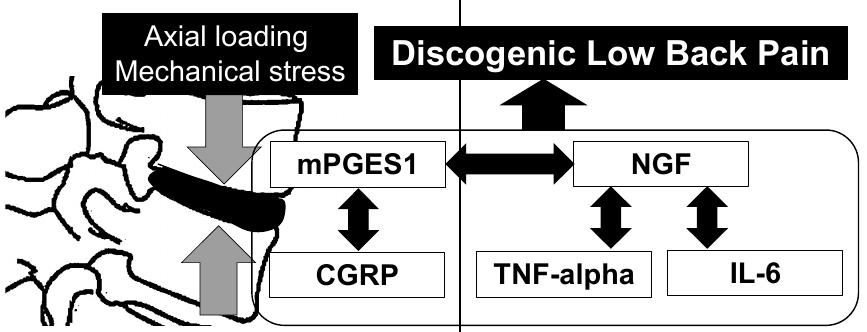
Figure 1. Relationship between mechanical stress on intervertebral discs and pain-related molecule expression.